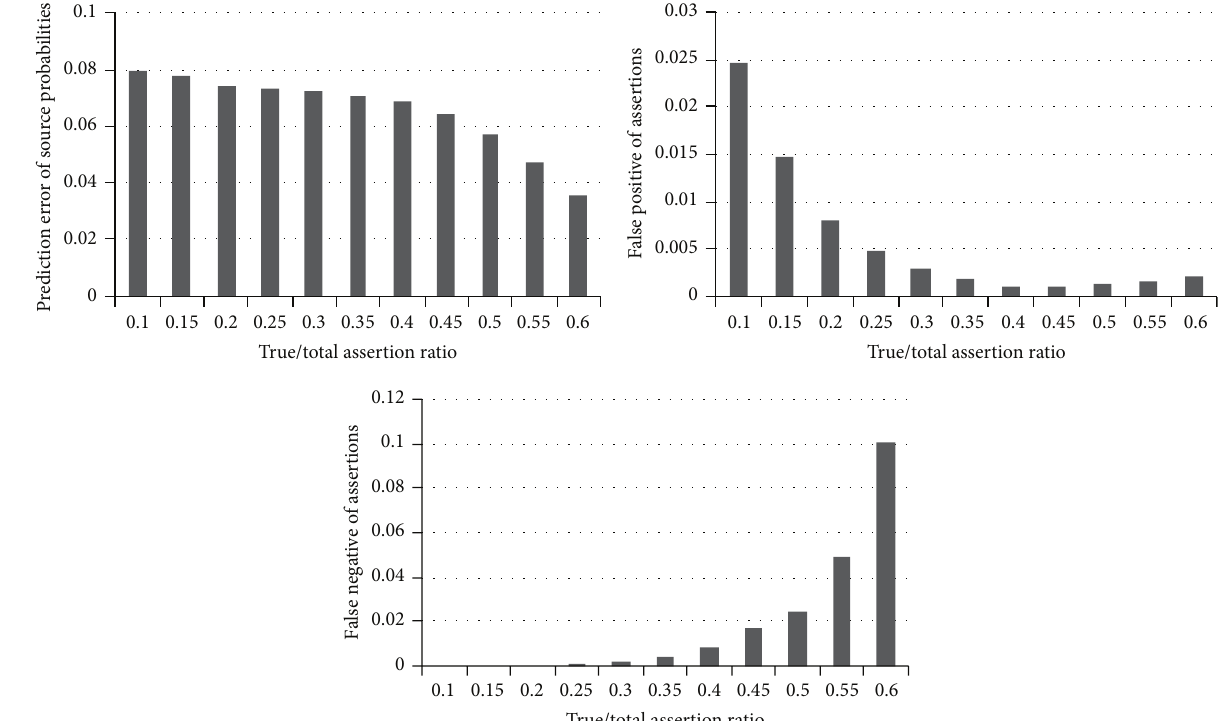
Figure 4: Prediction accuracy versus varying number of